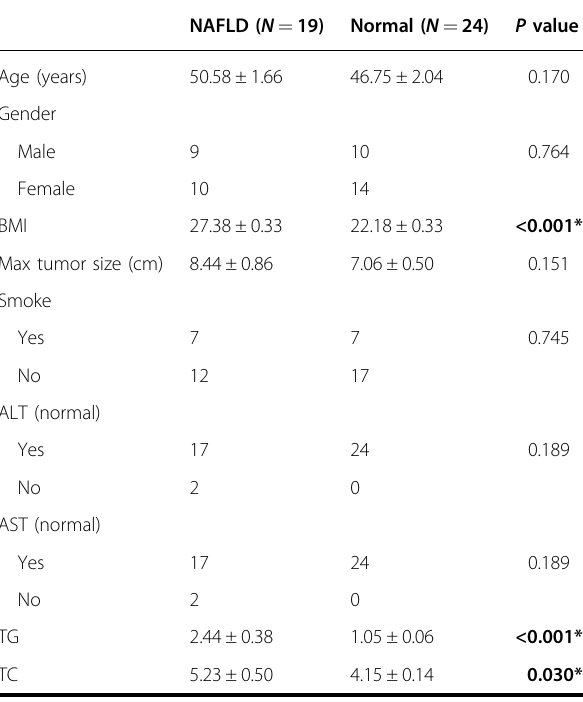
Bold values represent statistical